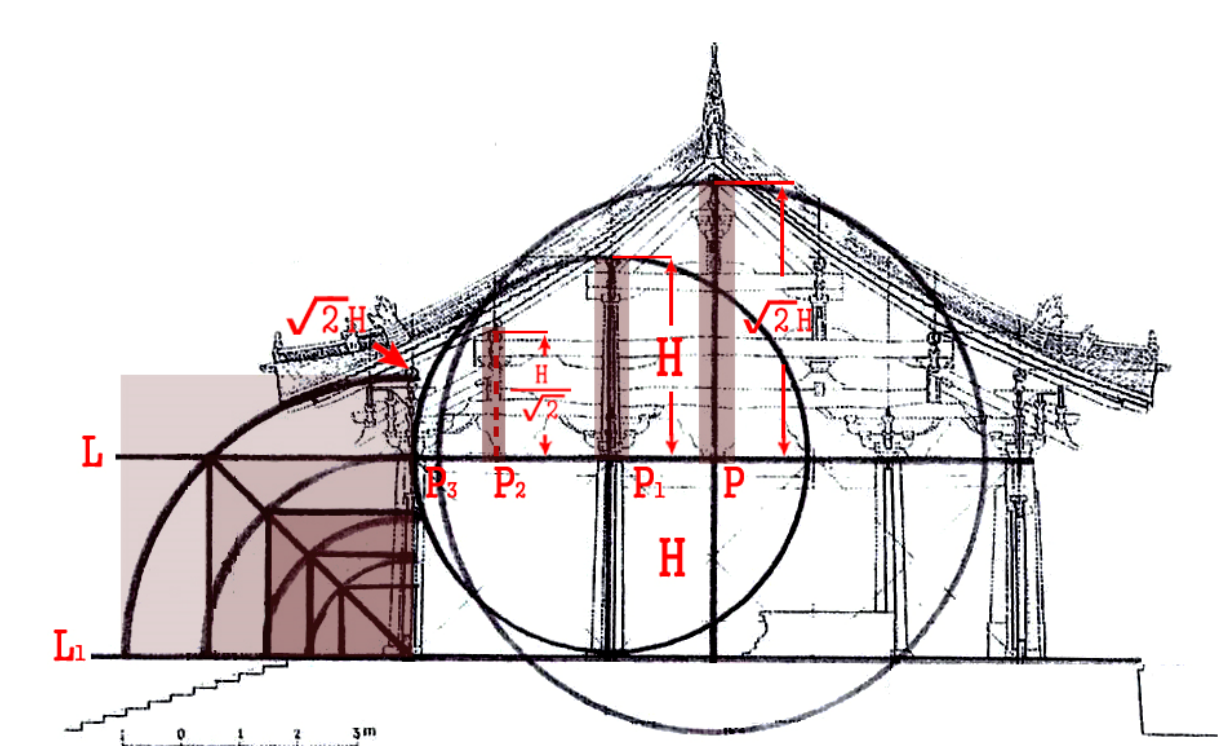
Figure 18. Main Hall of Chuzu’an Hermitage at Shaolinsi Monastery. Proportional analysis of the sectional elevation (H = eave column height, Ø = circle diameter), Adapted from Wang et al. (2011, p. 288).